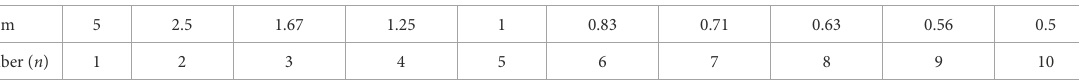
TABLE 1 The relationship between the slabbing number and rock slab